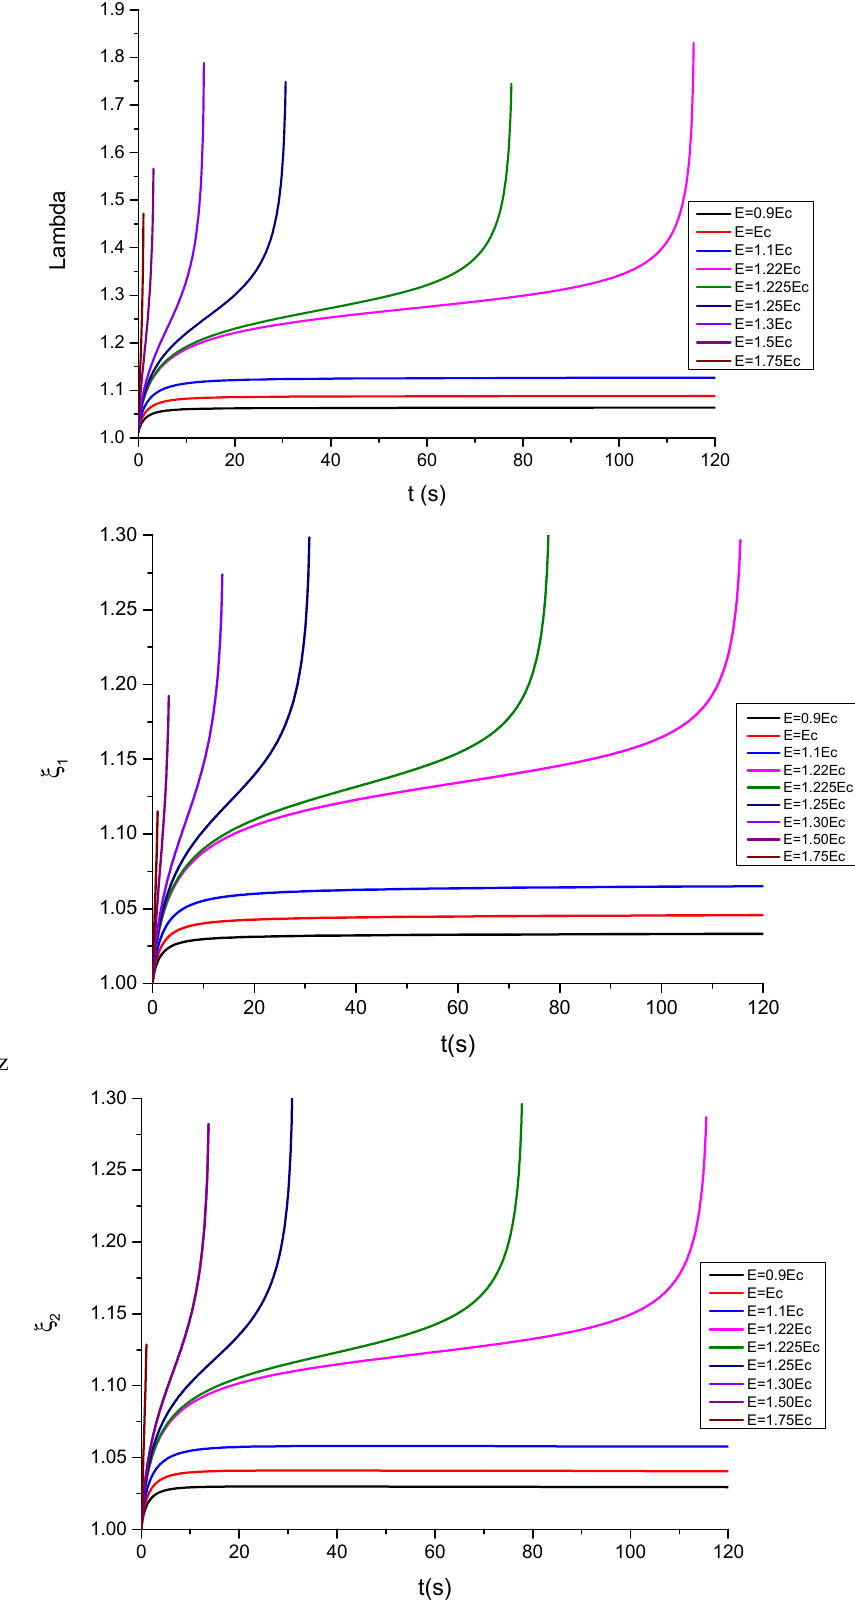
and  Figure 6. Plots showing the evolution of λ ,  as a function of time for different values of the electric field E, for the Figure 6. Plots showing the evolution of λ , ξ 1 and ξ 2 as a function of time for different values of the (cid:2869) (cid:2870) case of compliant electrodes without mechanical stresses. electric field E, for the case of compliant electrodes without mechanical